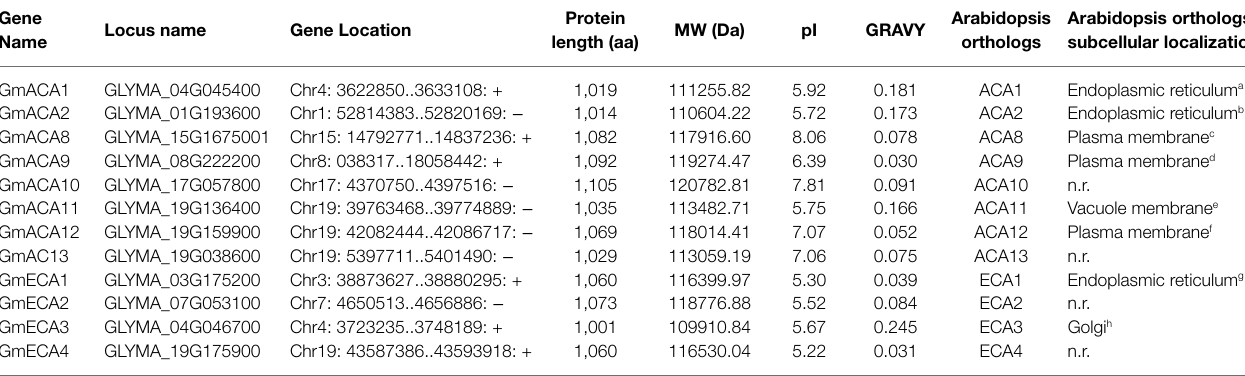
TABLE 1 | Summary of Ca 2+ -ATPase genes in Glycine max and the identity of Arabidopsis